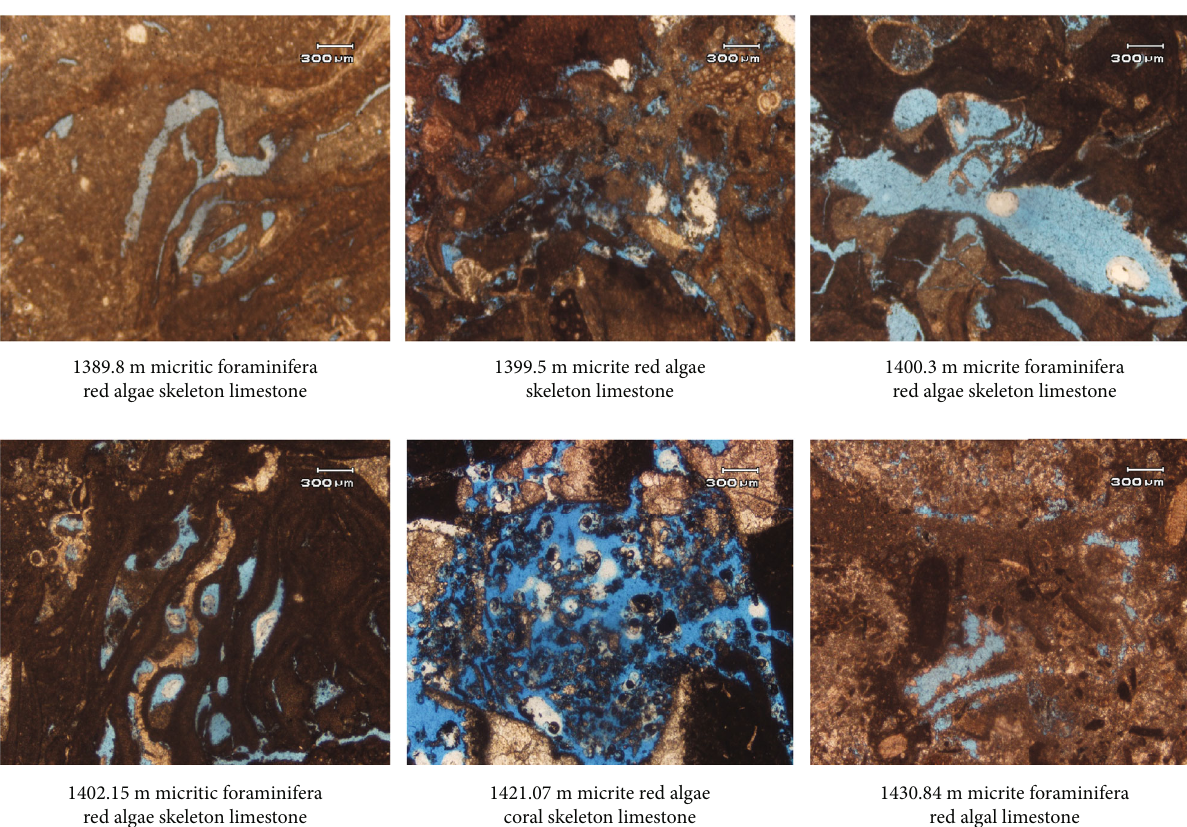
Figure 5: The casting thin-section photograph of the corresponding depth of NMR core in well